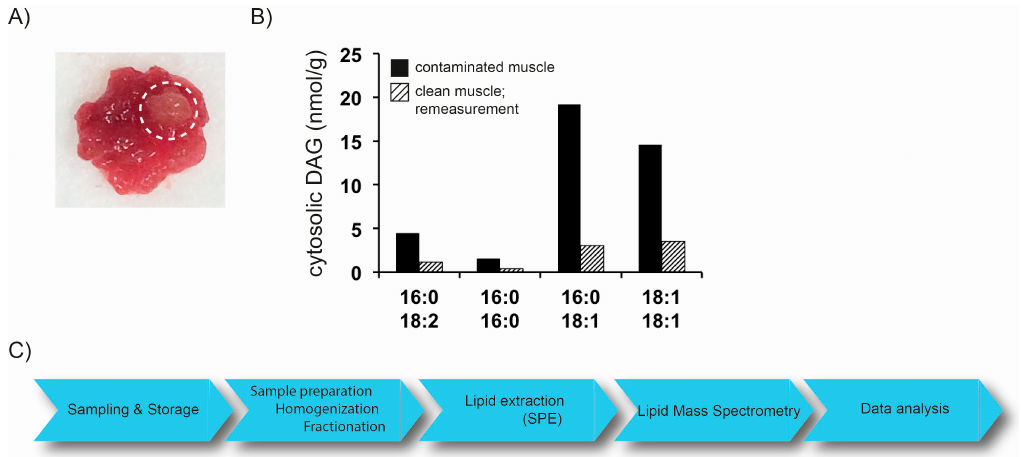
Figure 2. ( A ) Representative image of human muscle (musculus vastus lateralis) biopsy sample. Biopsy was taken using a Bergstrom needle. White circle highlights aggregates of adipocytes; ( B ) analysis of cytosolic DAG concentration using LC-MS/MS. Human muscle biopsy sample with extramyocellular fat contamination was homogenized, fractionated and DAG in the cytosolic fraction were analyzed. A sample from the same biopsy, without any visible extramyocellular fat contamination was processed and analyzed the same way (Interassay variation coefficient of the applied LC-MS/MS method: maximum 4.8%, for the indicated DAG species); ( C ) schematic illustration of lipidomics workflow.